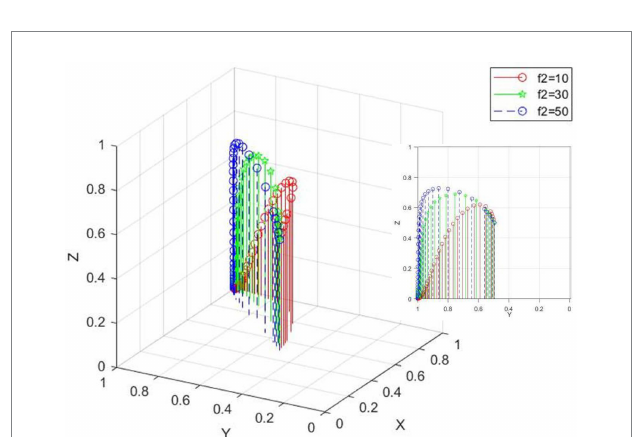
FIGURE 11 Impact map of the costs of strict government regulation (Scenario 1).